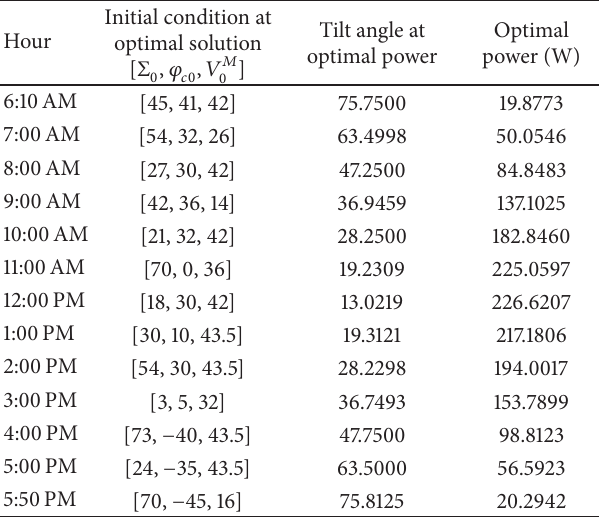
Table 5: The optimal power and the corresponding tilt angle by GA for June 10,